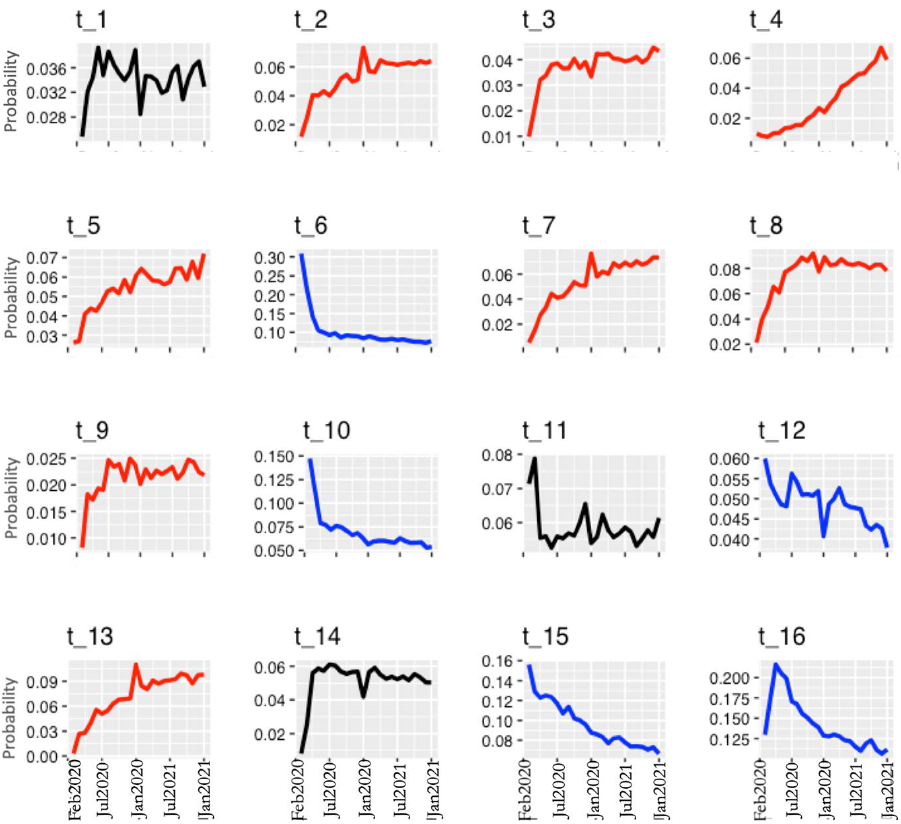
Figure 3. Topic trends research in COVID-19 during February 2020-January 2022.The red color indicates topics with increasing tendency, blue with decreasing tendency, and black fluctuating.